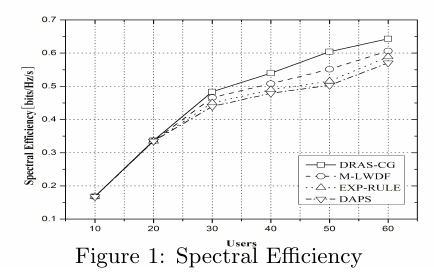
Figure 1: Spectral Efficiency